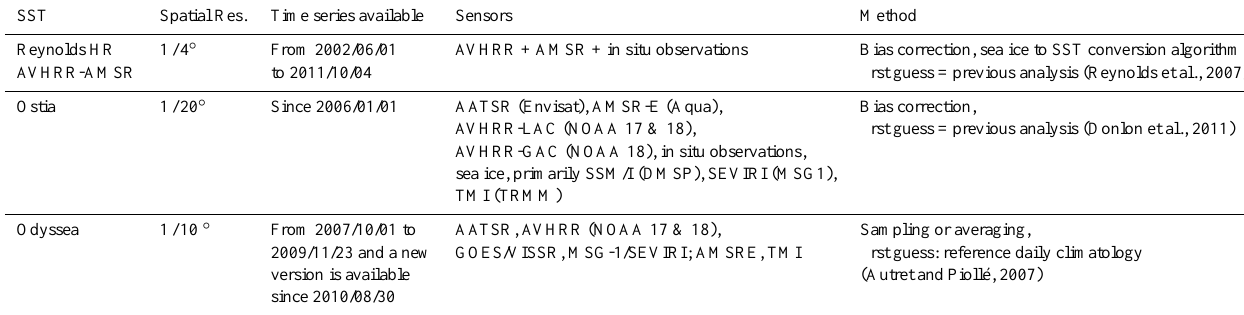
Table 1. Description of the L4 SST products